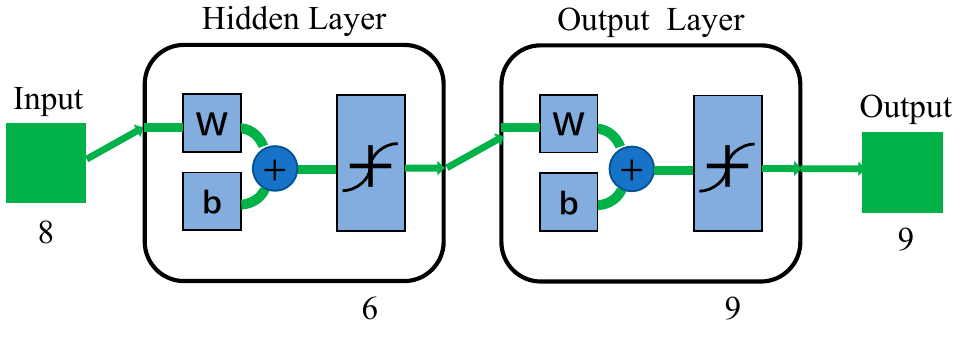
Figure 2. Schematic diagram of BP neural network structure.